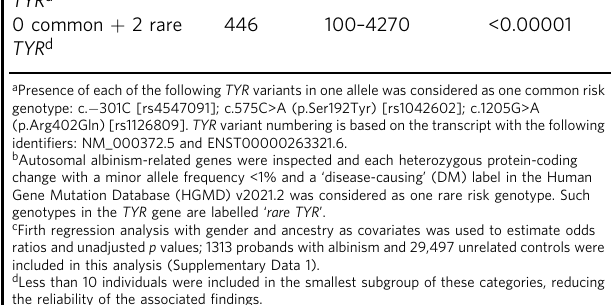
Fig. 3 High-level molecular diagnoses in 1208 probands from the University Hospital of Bordeaux albinism cohort. It was not possible to detect a molecular diagnosis in 24% of cases ( ‘ unknown ’ category). The following genes were implicated in the remaining probands: TYR (34%), OCA2 (19%), SLC45A2 (8%), GPR143 (5%), Hermansky-Pudlak syndrome (HPS) related genes (5%), SLC24A5 (2%), other albinism-related genes (3%). A signi fi cant subset of cases with TYR -related albinism was found/ presumed to carry either the TYR c.[ − 301C;575A;1205A] or the TYR c.[ − 301C;575 C;1205A] haplotype (15% in heterozygous state [ ‘ TYR